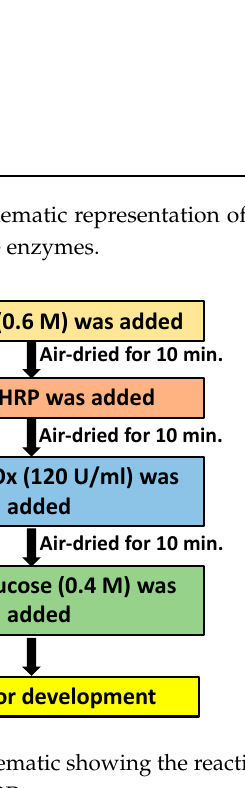
Figure 6. Schematic showing the reaction mechanism for color development using different concentrations of HRP.